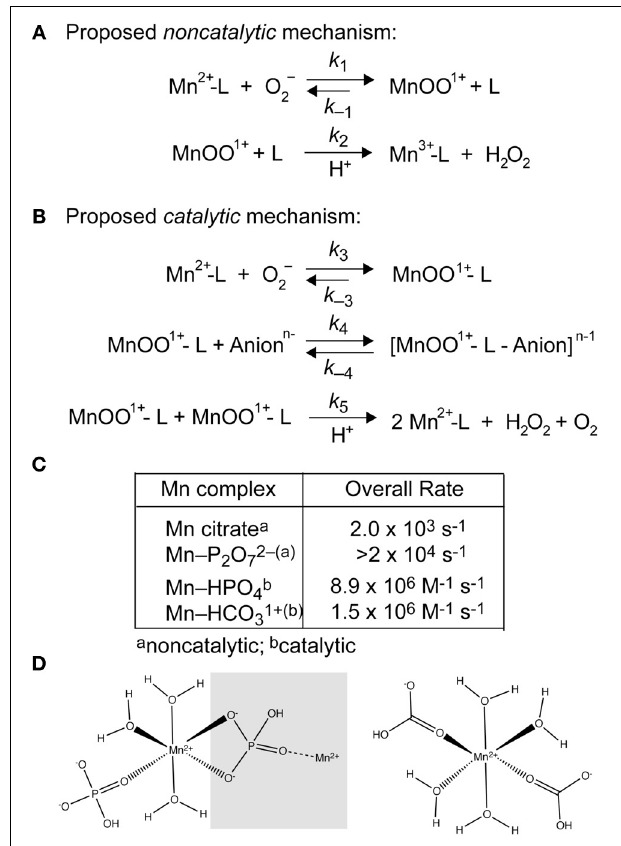
FIGURE 3 | Superoxide disproportionation by LMW-Mn complexes (Barnese et al., 2012). (A) Plausible noncatalytic mechanism of the reaction of O 2 − with [Mn(II)-P 2 O 7 ] 2 − and Mn(II)-citrate. L, pyrophosphate or citrate. (B) Proposed catalytic mechanism of the reaction of O 2 − with [Mn(II)-HPO 4 ] and [Mn(II)-HCO 3 ] + leading to the catalytic disproportionation of O 2 − . L, phosphate or carbonate; Anion n − represents an additional bound anion to the form the intermediate. (C) Overall rate constants for the non-catalytic and catalytic disproportionation of O 2 − , the latter of which incorporates the MnOO + dependence of k 5 . Rate law simulations reveal that 91 μ M MnHPO 4 (165 μ M Mn(II), 5mM phosphate), and 25 μ M MnHCO + 3 (formed by 36 μ M Mn(II) and 5mM carbonate) gives rise to a steady-state [O the ≈ 100 μ M range is expected to be sufficient to resist the effects of superoxide stress, as found previously in yeast; these studies also physically document the presence of MnHPO 4 species in whole cells (McNaughton et al., 2010). The same may well be true for manganese-centric bacterial pathogens vs. iron-centric E. coli (Aguirre et al., 2013; Sharma et al., 2013) (see Figure 1B ). (D) Chemical structures of “layered” Mn-HPO 4 , where the gray box encompasses the next layer in the crystal lattice ( left ) (Krishnamohan Sharma et al., 2003) and a calculated model of frozen neutral [Mn(HCO 3 ) 2 ] from ENDOR studies ( right ) (Potapov and Goldfarb, 2008).